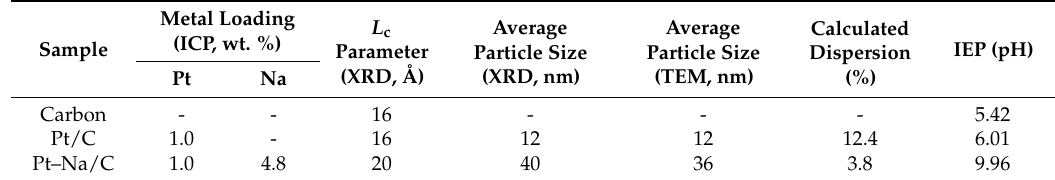
Table 1. ICP-MS analysis, XRD parameters, particle size, estimated dispersion by TEM and measured isoelectric point (IEP) for the raw carbon support and the prepared catalysts. Metal Loading (ICP, wt.